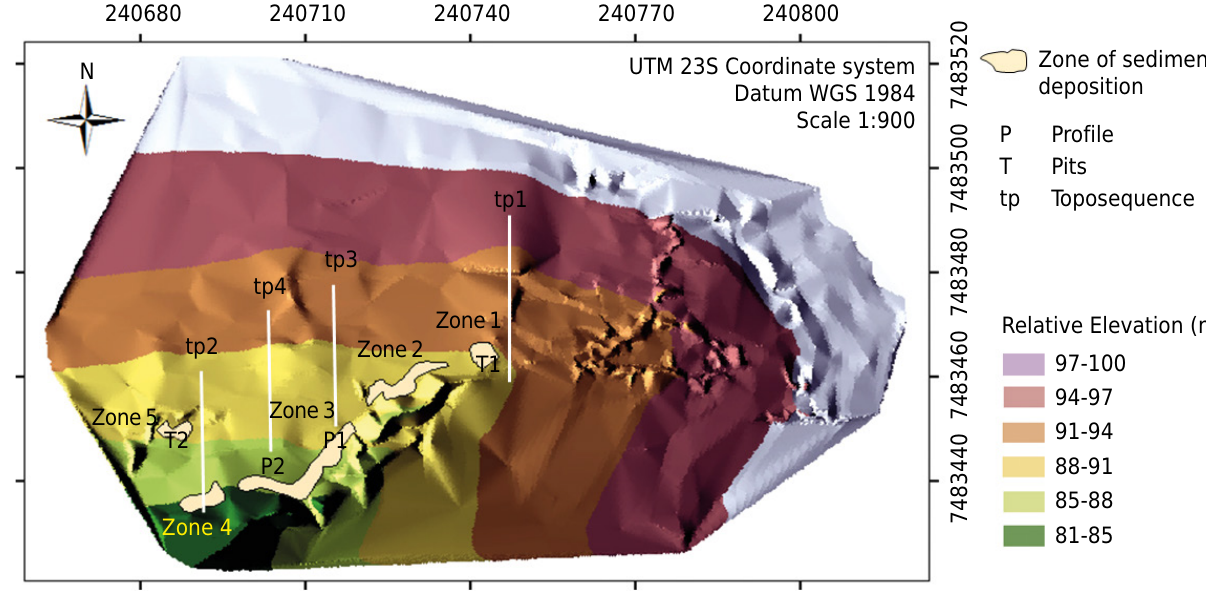
Figure 4. Digital model of the terrain showing the location of the sediment